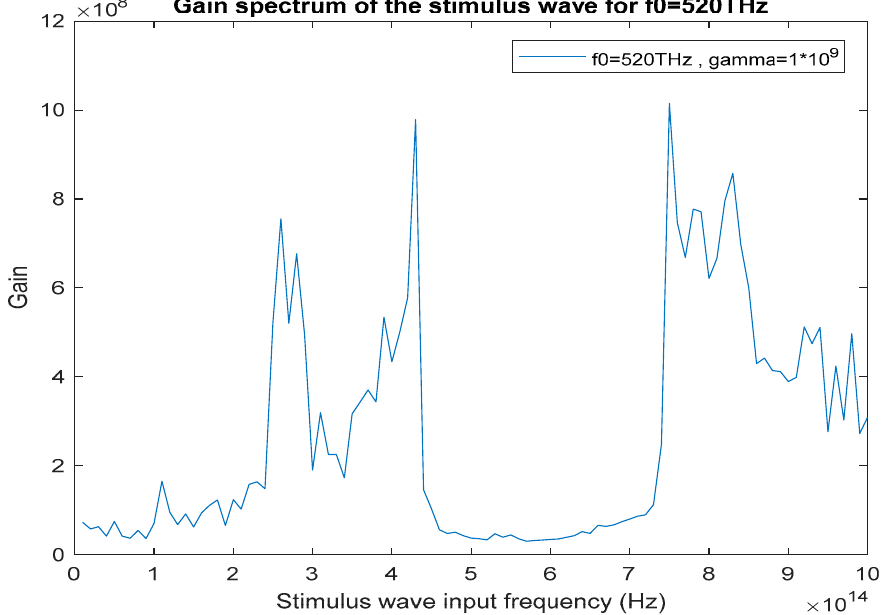
Figure 14. Gain spectrum of the stimulus wave as measured at x = 11 µ m for f 0 = 520 THz, γ = 1 × 10 9 Hz.